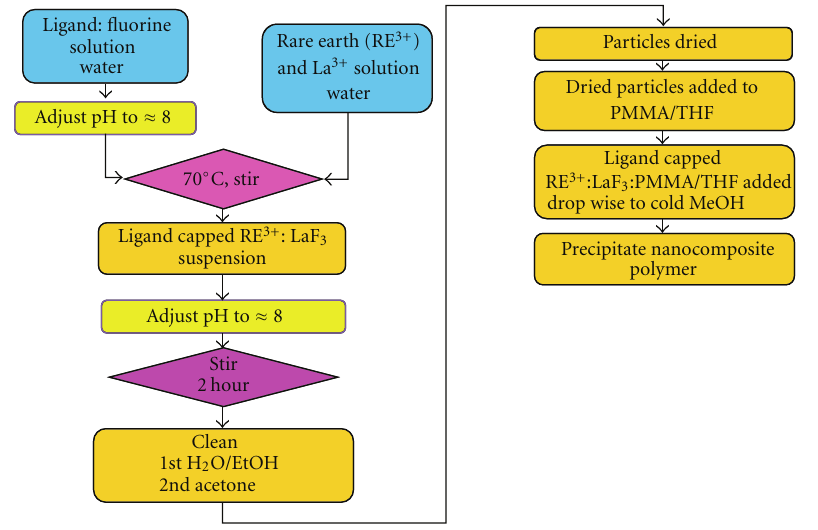
Figure 3: Flow chart of nanoparticle synthesis.